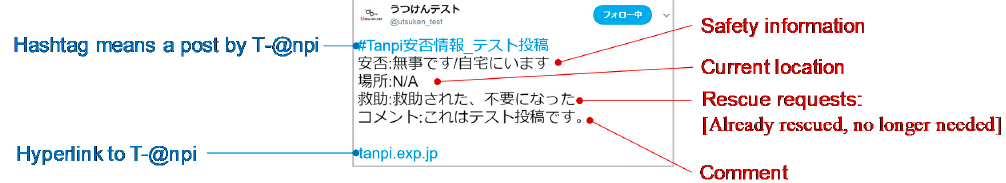
Figure 6. Example tweet of the safety information posted by a safe user from an unspecified location.